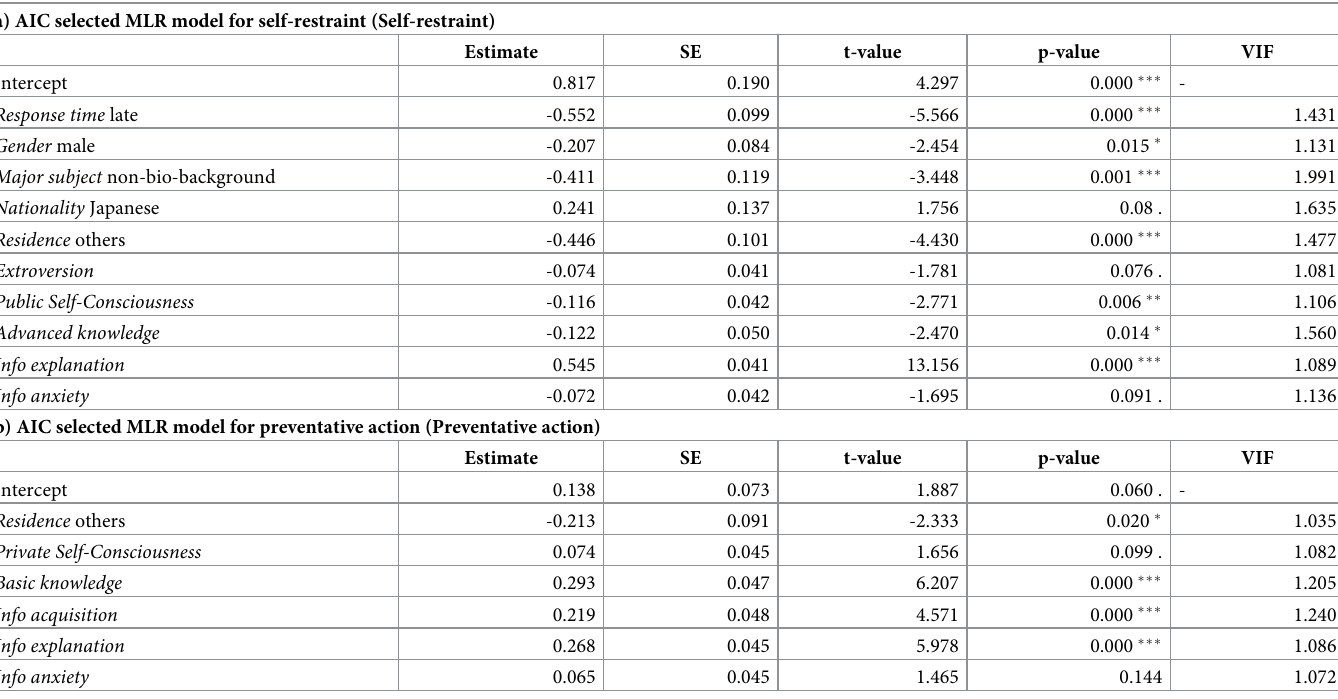
Table 5. AIC selected MLR models for university students’ preventative practices and